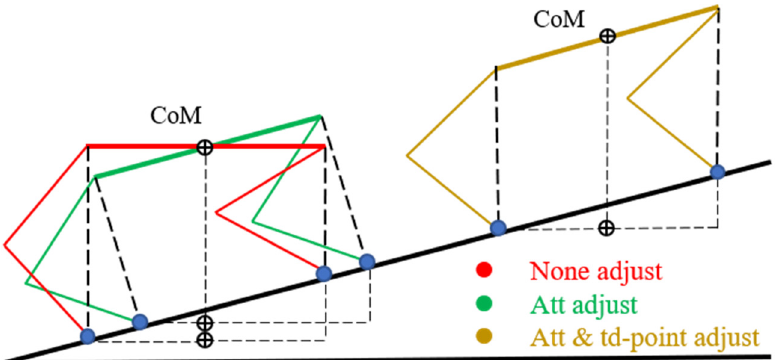
Figure 6. The adjustment of foot touch-down point. According to the current posture of the robot, the yellow robot plans in the inertial frame so that the foot is directly beneath the hip on the slope. Equation (11) is calculated under the inertial frame and mapped back to the hip frame through the rotation matrix.